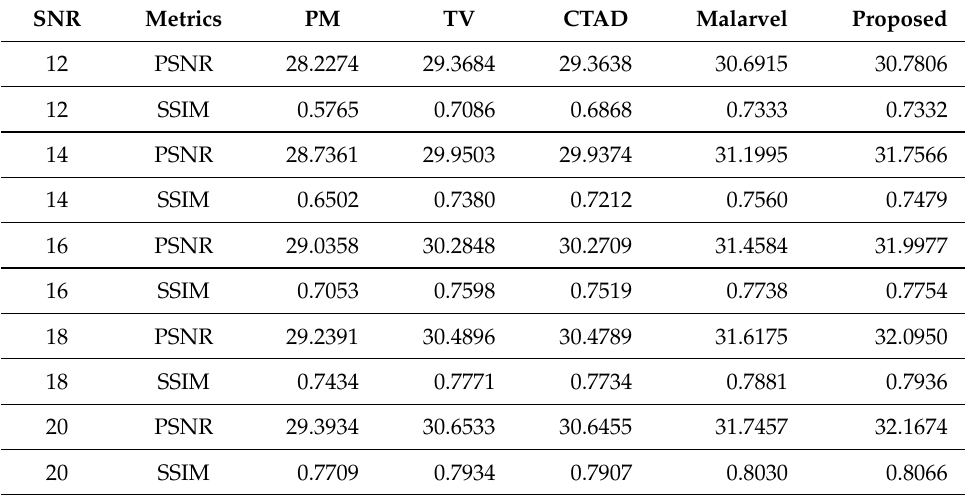
Table 5. Dogs image experiment results evaluation.